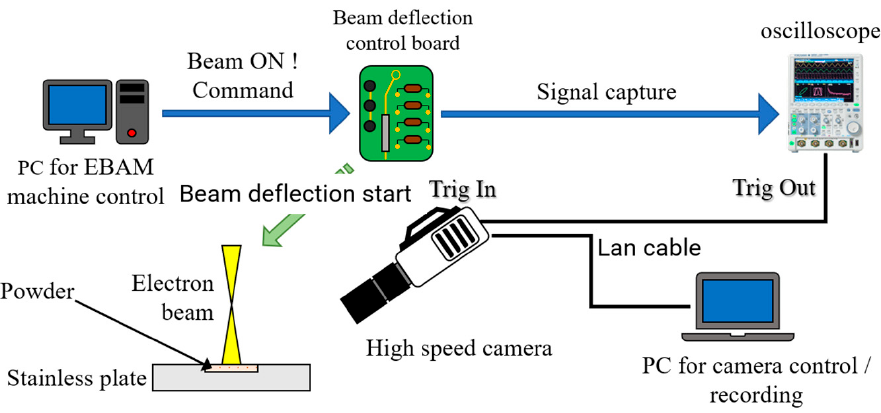
Figure 2. Schematic of the smoking experiment equipment.